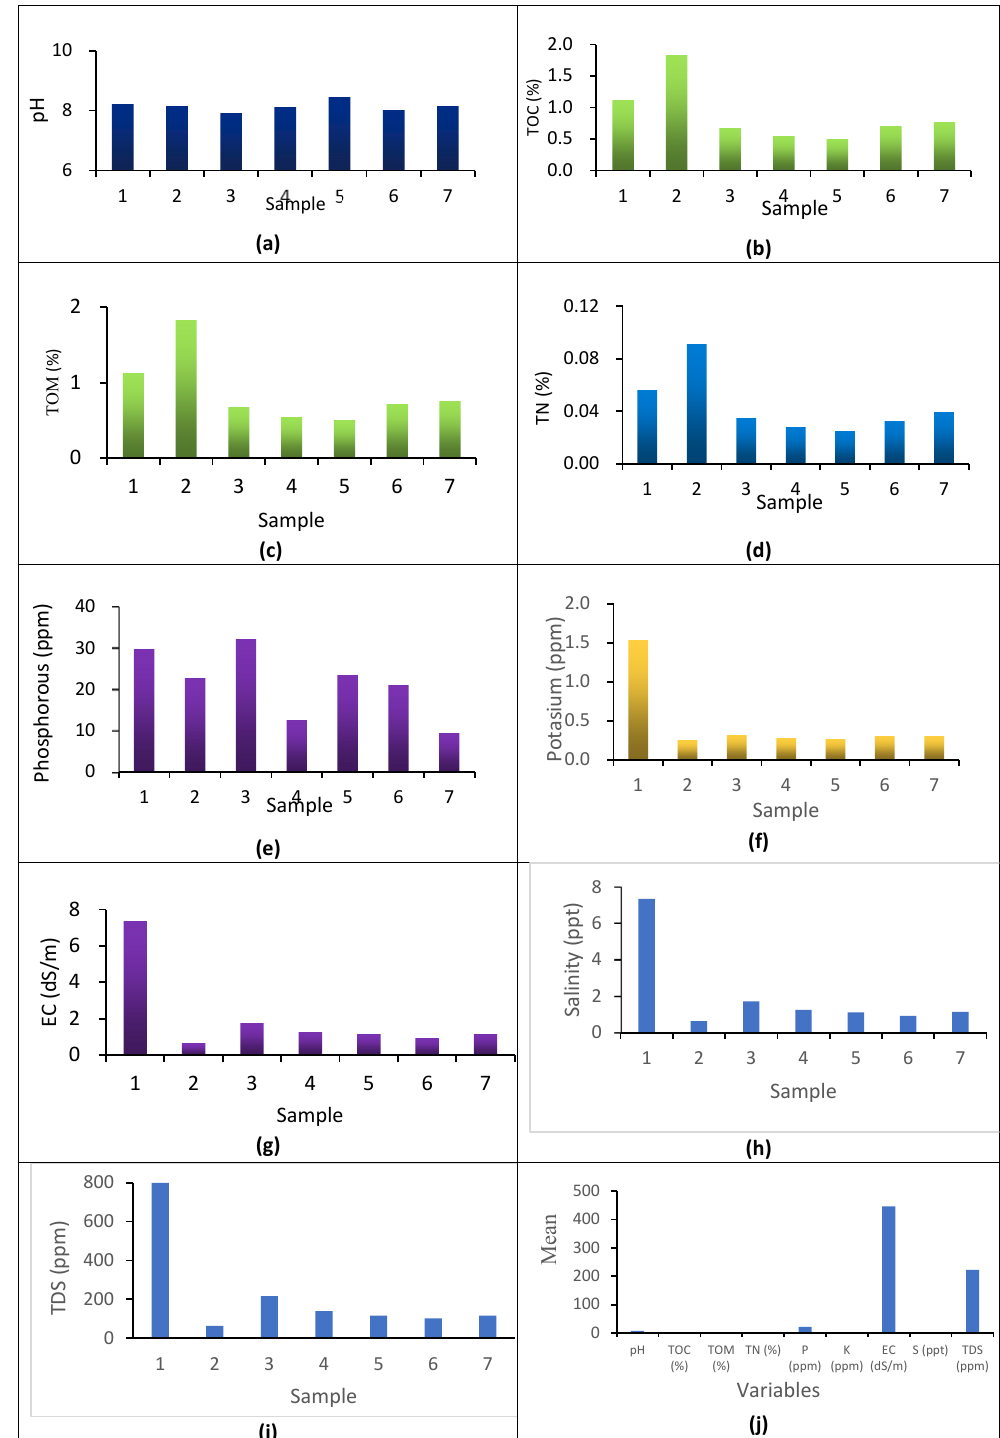
Fig. 2: Station wise value of (a) pH, (b) TOC, (c) TOM, (d) TN, (e) Phosphorous, (f) Potassium, (g) EC and (h) Salinity (i) TDS and (j) mean of variables of all soil samples